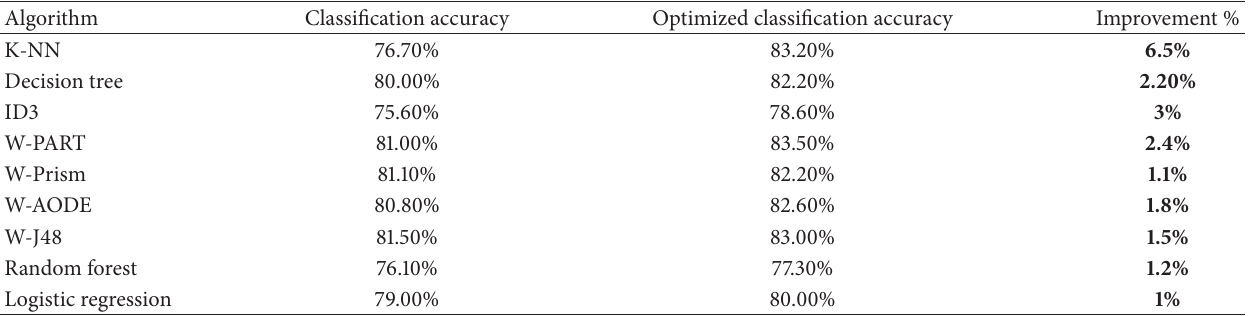
Table 9: Results of adult income dataset: comparison of optimized classification accuracy using GMC model with simple classification using different classifiers.